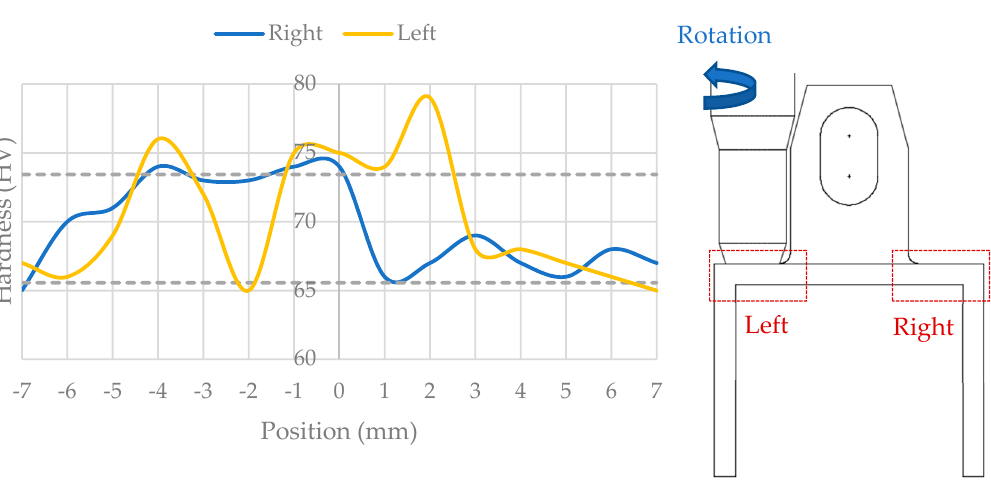
Figure 13. Horizontal hardness measurements.